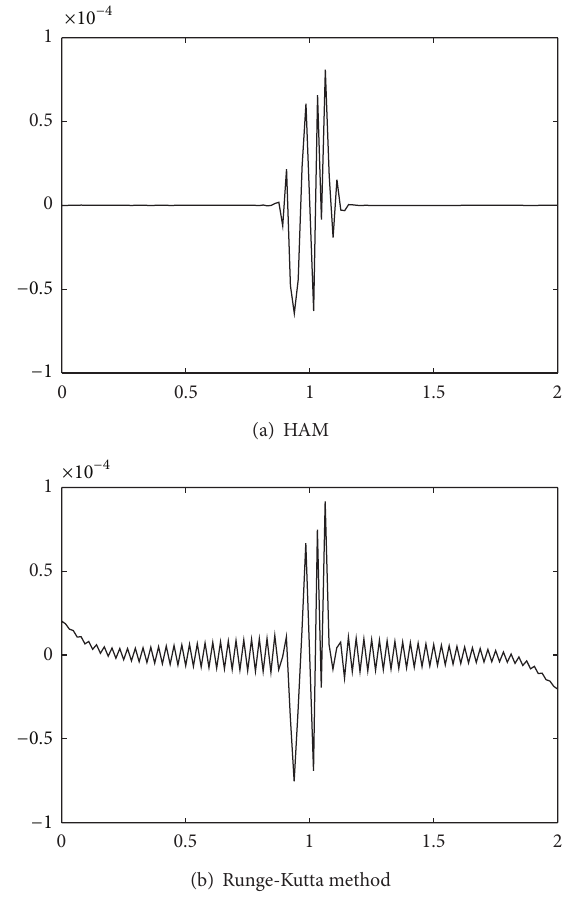
Figure 3: The computational errors of HAM the Runge-Kutta meth- od ( 𝑡 = 0.4 ). Table 2: Largest computational errors of the Burgers